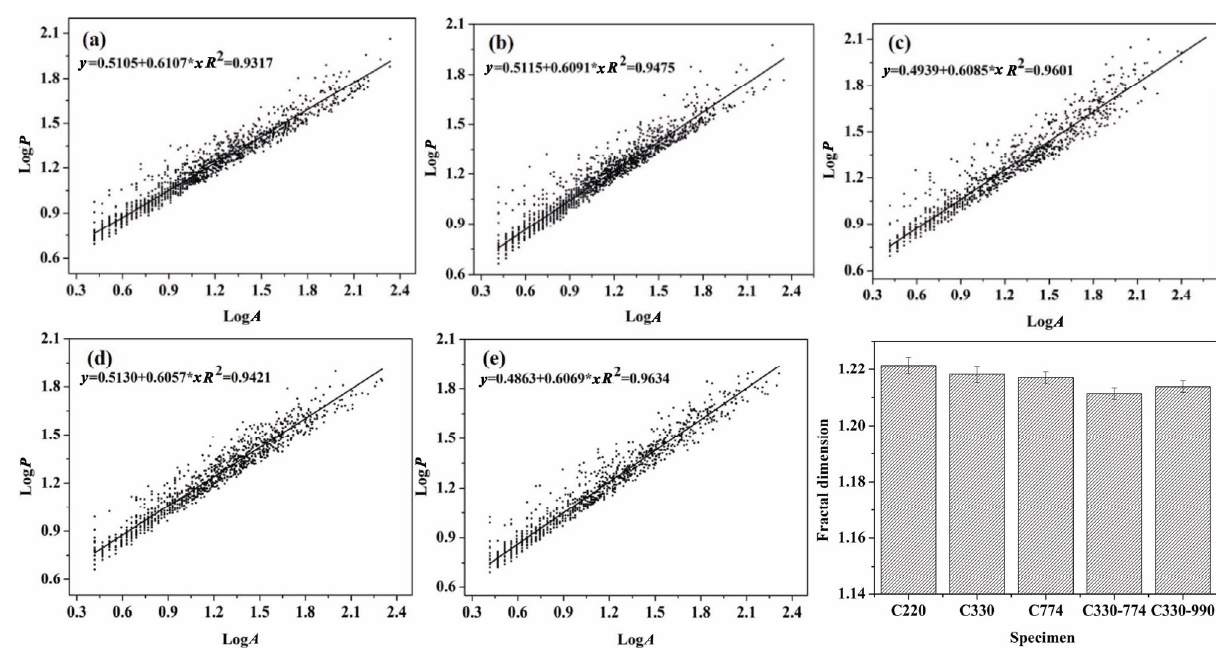
Fig. 7 Fractal dimension of specimens prepared with different types of carbon black.